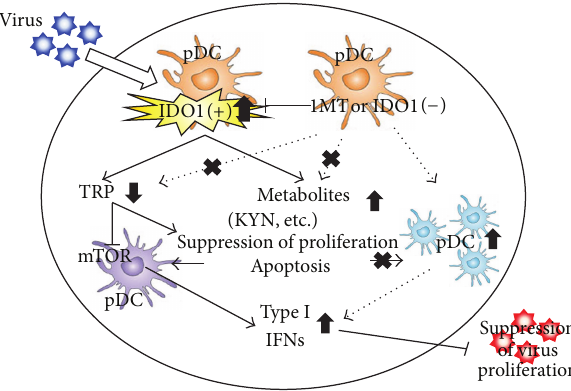
Figure 4: The mechanism of IDO1 regulation on viral infectious diseases. Innate defense occurs when pathogens contact or invade host cells and elicit the production of cytokines and chemokines, which in turn induce an influx of immune cells that affect pathogen clearance. Type I IFNs are critical mediators of innate immunity and limit disease caused by many viruses [73, 86]. The enhancement of TRP breakdown by IDO1 regulates the signal pathway for IFNs production, and TRP metabolites might contribute to the function of IFNs producing